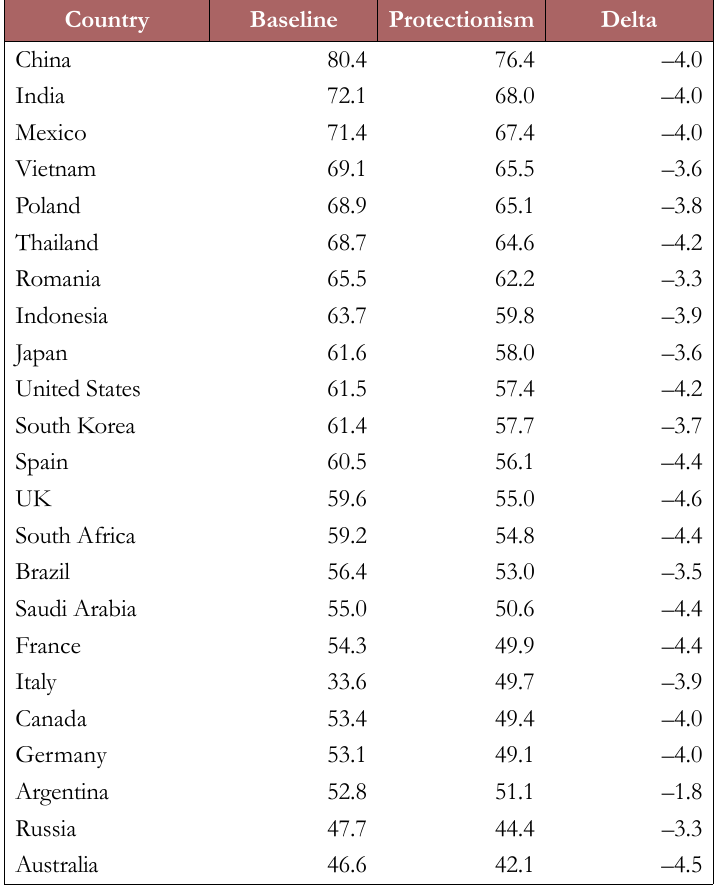
Table 10. Protectionism